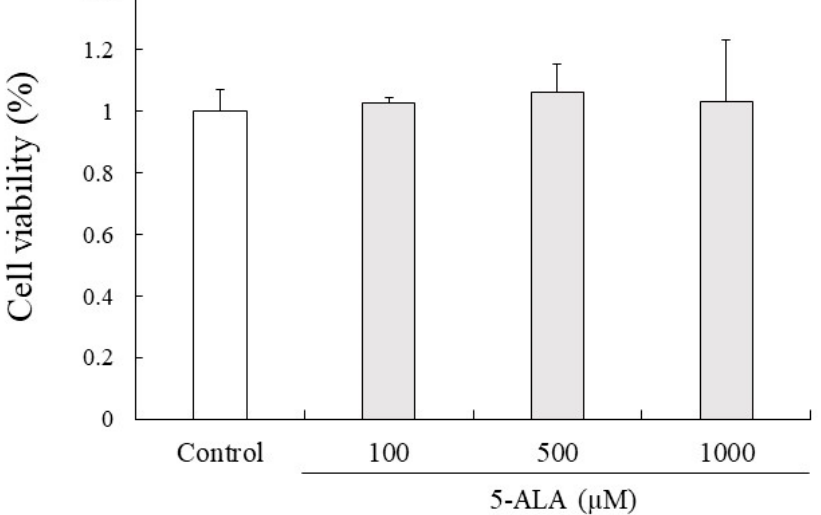
Figure 4. 5-ALA has no effect on viability of RAW264.7 cells. Cells (0.8 × 10 4 cells/well) were precultured for 24 h and incubated with or without 5-ALA concentrations indicated for 24 h. Data represent the mean ± SD ( n = 3).